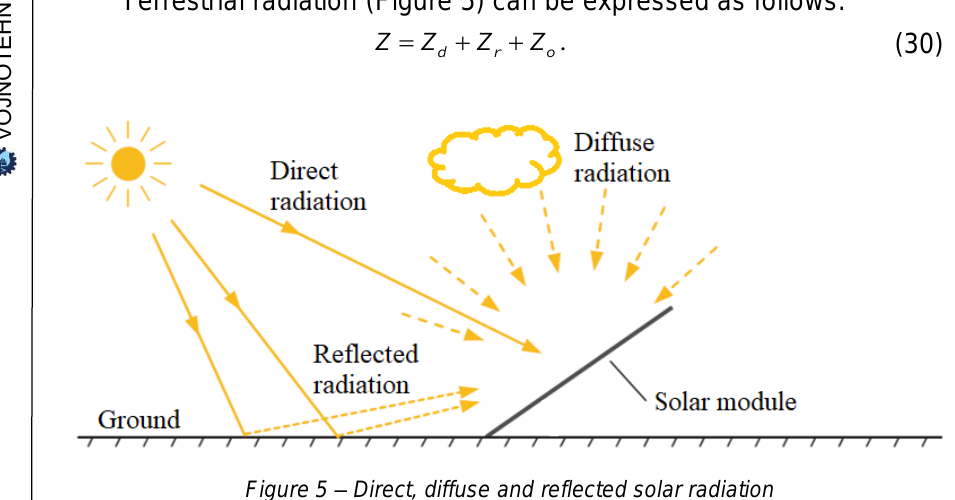
Figure 5 – Direct, diffuse and reflected solar radiation Рис. 5 – Прямое, рассеянное и отраженное солнечное излучение Слика 5 – Директно, дифузно и рефлектовано сунчево